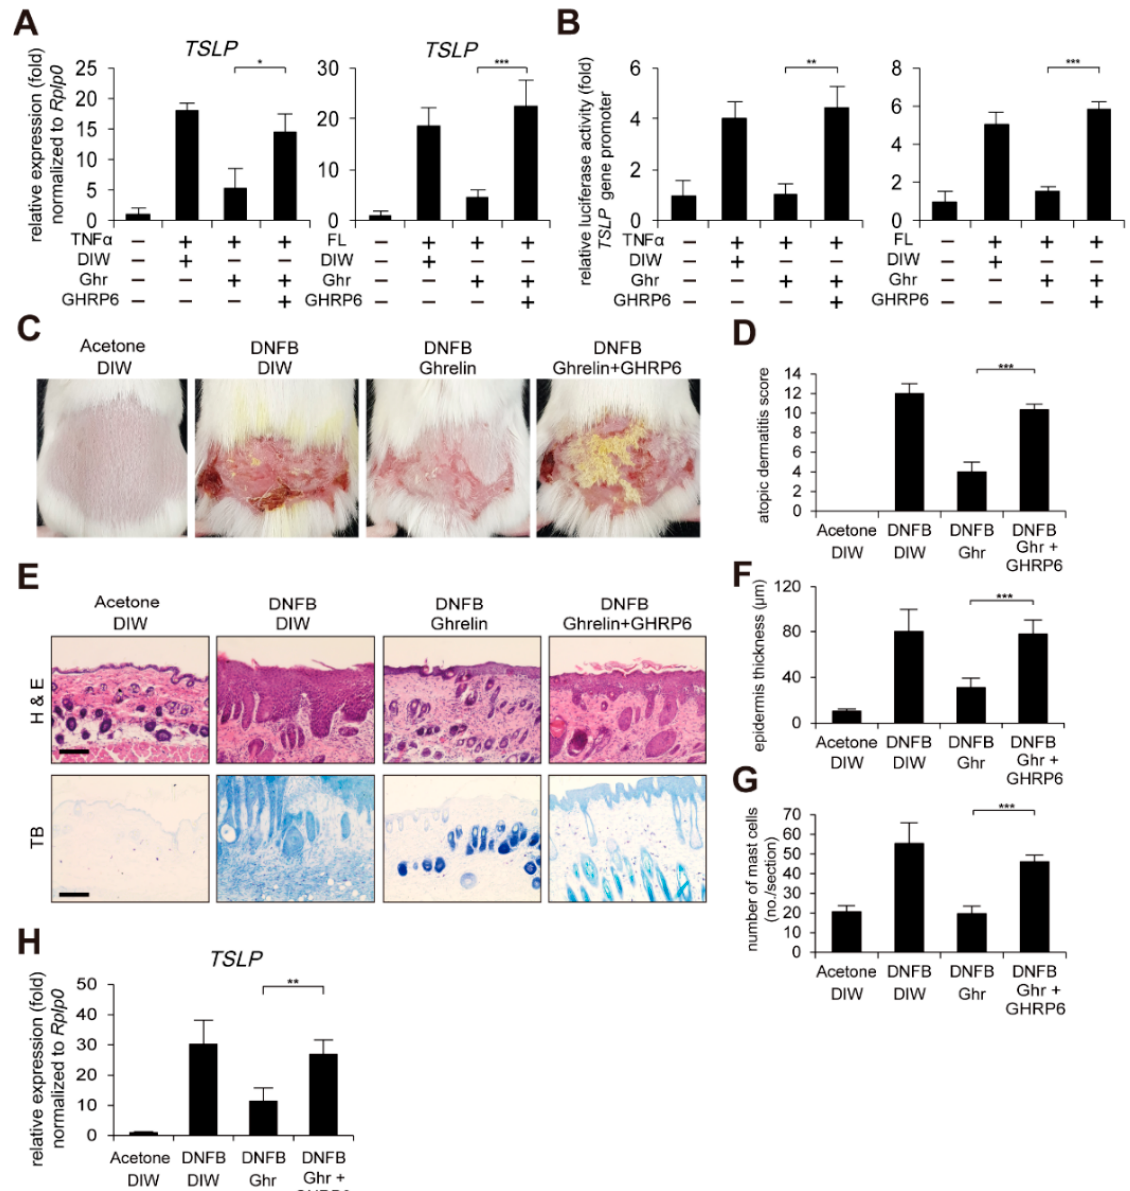
Figure 3. GHSR1a antagonist abolishes ghrelin-induced alleviation of AD-like phenotypes. gene activation in HaCaT keratinocytes treated with TNF α or bacterial flagellin (FL). Real-time